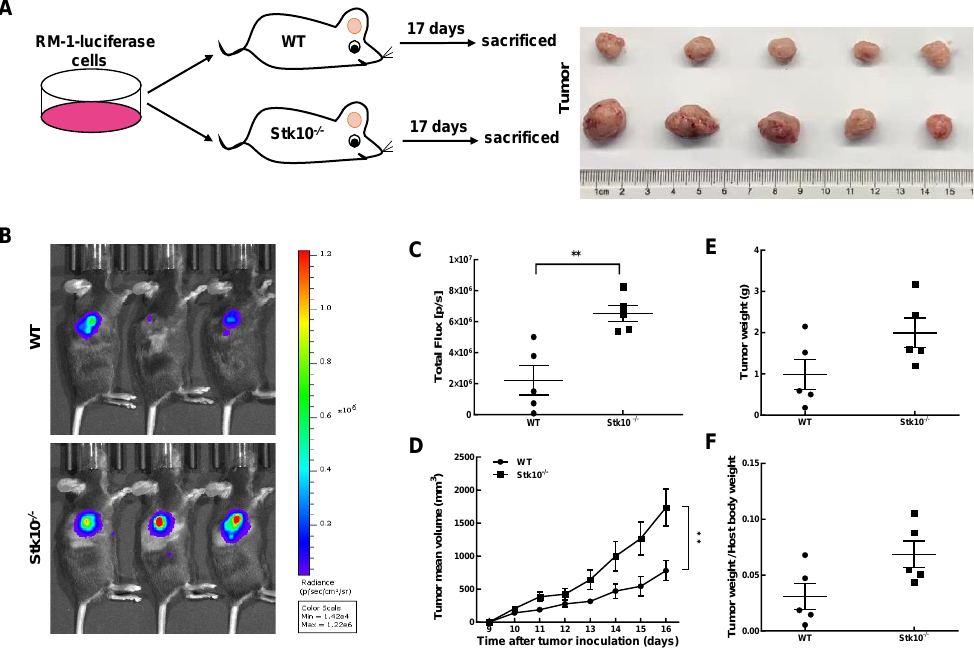
Figure 3. Deletion of Stk10 promoted RM-1-luc tumor growth in C57BL/6J mice. RM-1-luc murine prostate cancer cells were directly injected into WT and Stk10 knockout mice (n = 5/group). ( A ) A schematic diagram of the tumor-bearing mouse model and typical tumor photograph. ( B ) Detection of RM-1-luc tumors by in vivo fluorescence imaging. ( C ) Tumor luminescence intensity. ( D ) Tumor volume. ( E ) Tumor weight. ( F ) Ratio of tumor weight to host body weight. The results are represented as mean ± SEM from three independent experiments. Comparisons between groups were determined by Student’s t -test. ** p < 0.01.